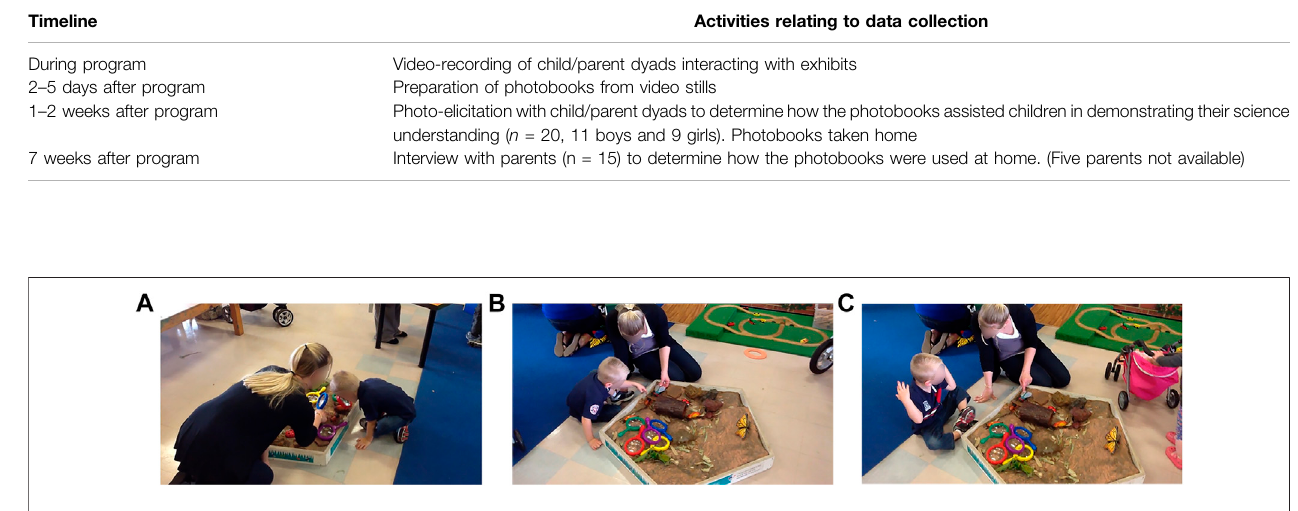
FIGURE 1 | A sequence of photograps showing a child and parent interacting with plastic